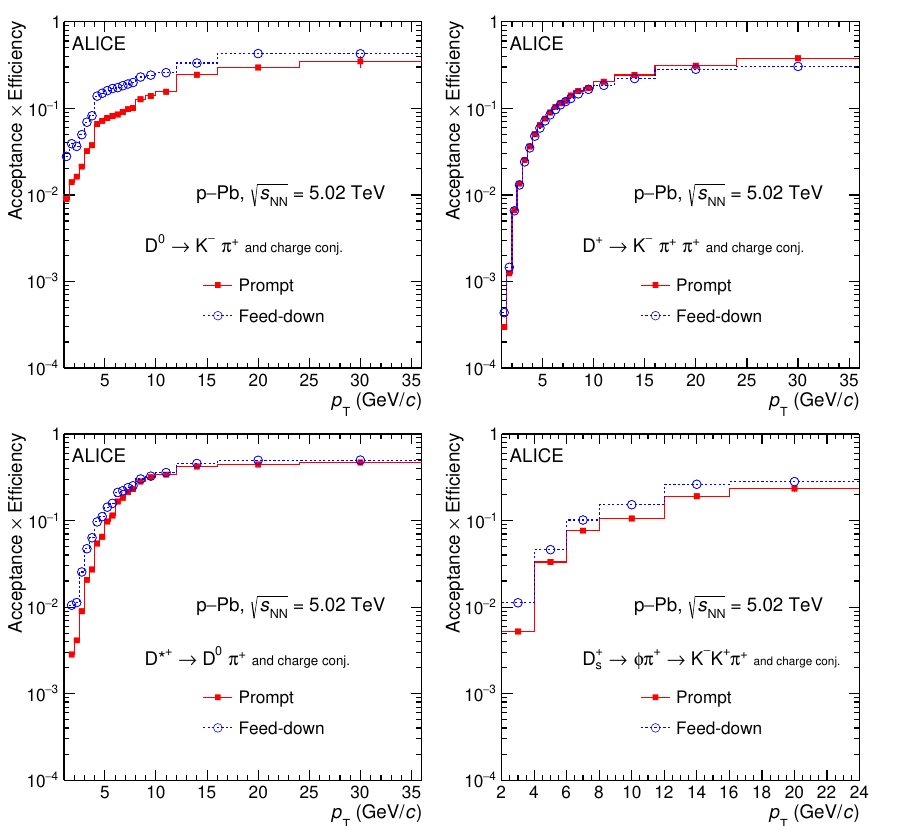
Figure 2 . The product of acceptance and e(cid:14)ciency for D 0 , D + , D (cid:3) + , and D + of transverse momentum in p{Pb collisions at and feed-down (dashed line) D mesons are